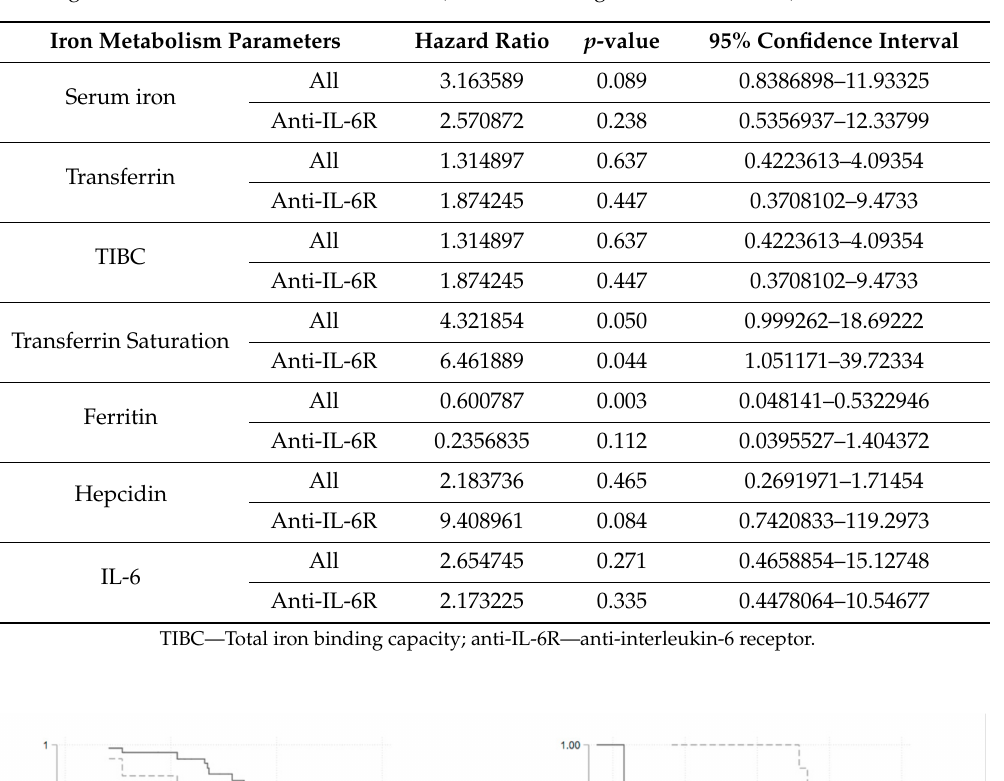
Table 5. Multivariate survival analysis for iron metabolism parameters. Hazard ratios presented are for being above the median for each variable (relative to being below the median).